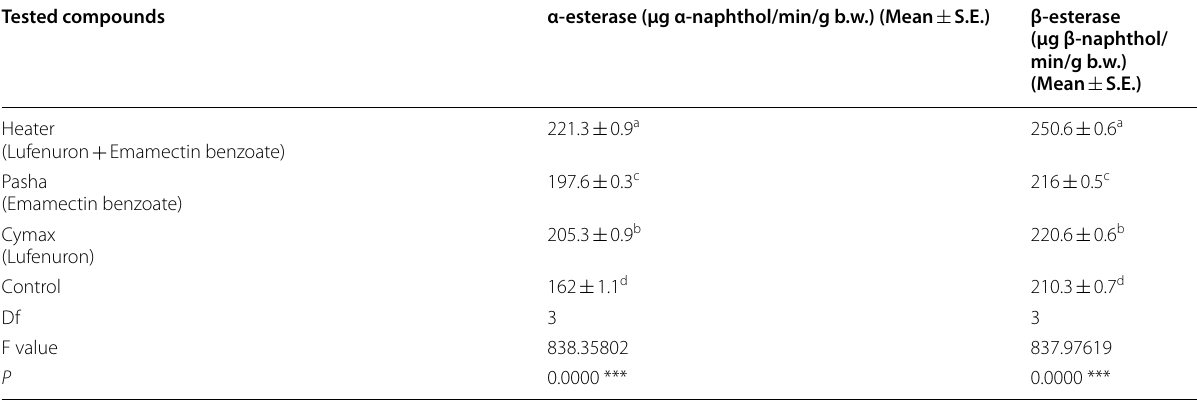
Table 6 Effect of the tested compounds on Chitinase activity, α‑ and β‑ esterases in 4th instar larvae of S. littoralis after treatment with LC 50